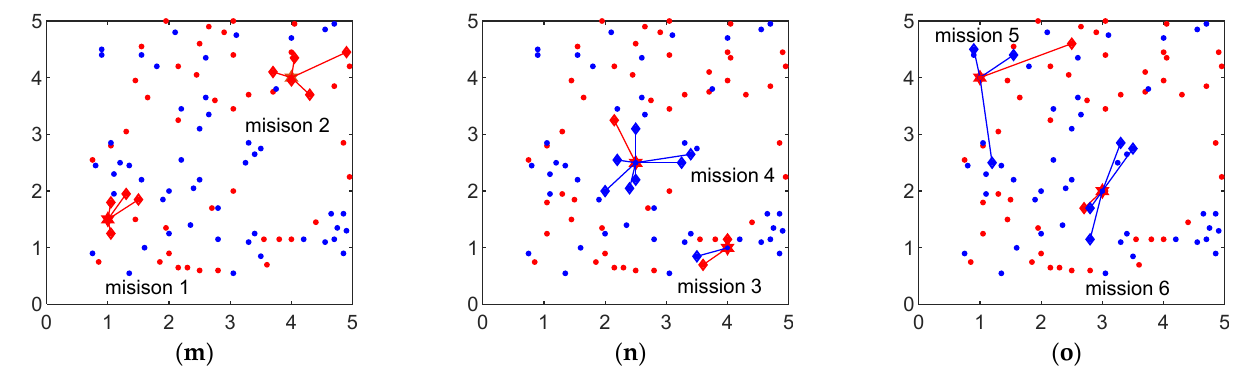
Figure 6. The comparison results of different algorithms: ( a ) GA for missions 1 and 2; ( b ) GA for missions 3 and 4; ( c ) GA for missions 5 and 6; ( d ) PSO for missions 1 and 2; ( e ) PSO for missions 3 and 4; ( f ) PSO for missions 5 and 6; ( g ) RL-SAM for missions 1 and 2; ( h ) RL-SAM for missions 3 and 4; ( i ) RL-SAM for missions 5 and 6; ( j ) DIRL-AM for missions 1 and 2; ( k ) DIRL-AM for missions 3 and 4; ( l ) DIRL-AM for missions 5 and 6; ( m ) DIRL-SAM for missions 1 and 2; ( n ) DIRL-SAM for missions 3 and 4; ( o ) DIRL-SAM for missions 5 and 6. Table 6. Optimization results of different algorithms.